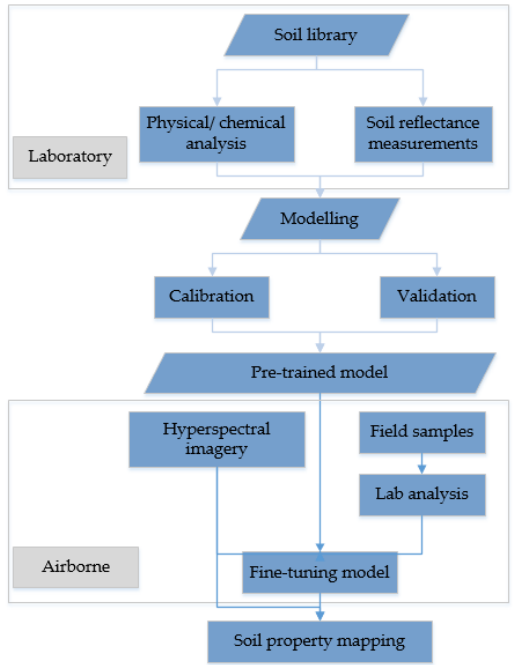
Figure 3. Schematic diagram of proposed workflow on transfer learning for soil property mapping.